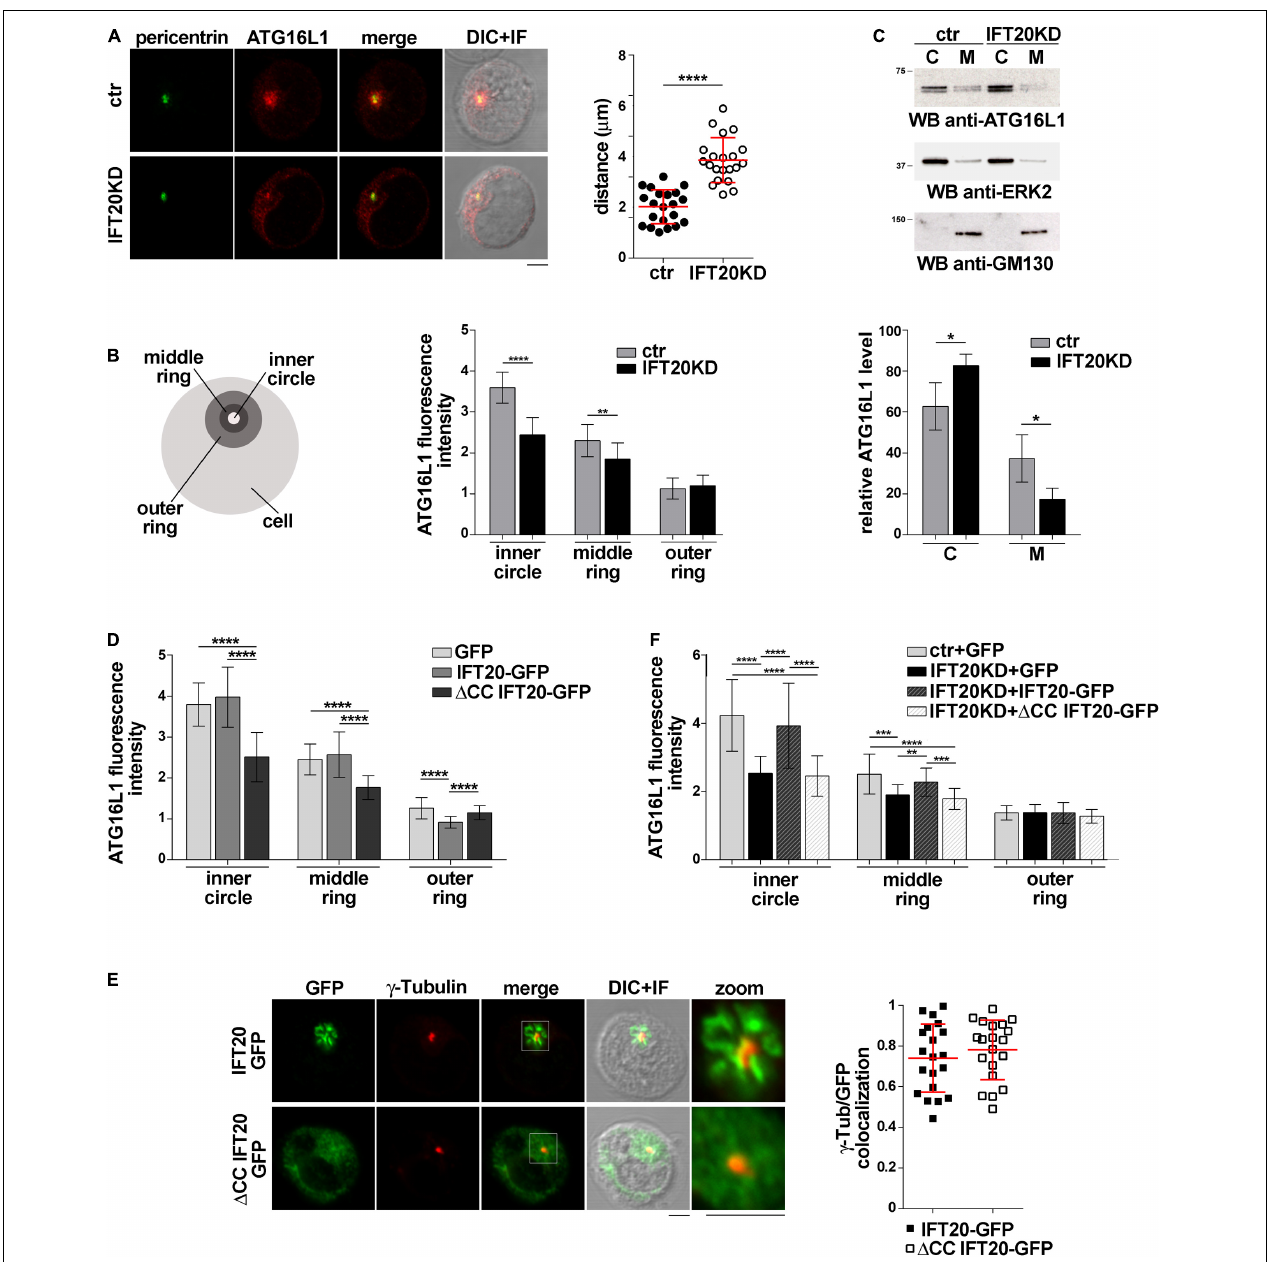
FIGURE 2 | IFT20 regulates the intracellular localization of ATG16L1. (A,B) Immunofluorescence analysis of ATG16L1 and the centrosomal protein pericentrin in control (ctr) and IFT20KD Jurkat cells. Representative medial optical sections and overlay of immunofluorescence and DIC images are shown (IF + DIC). Scale bars: 5 µ m. (A) The graph shows the quantification of the distance of ATG16L1 + vesicles from the centrosome (mean ± SD, 21 cells; n = 3; Student’s t -test). (B) Histogram showing the quantification of fluorescence intensity in the concentric regions indicated in the scheme and defined from the point of ATG16L1 maximal intensity (mean ± SD, ≥ 20 cells/sample; n = 3; Mann–Whitney test). (C) Immunoblot analysis of ATG16L1 in cytosolic (C) and membrane (M) fractions purified from control and IFT20KD Jurkat cells. The cytosolic protein ERK2 and the cis -Golgi marker GM130 were used to assess the purity of cytosolic and membrane fractions, respectively. The migration of molecular mass markers is indicated. The histogram shows the quantification of the percentage of ATG16L1 in the cellular fractions obtained from 4 independent experiments (mean ± SD; Student’s t -test). (D) Immunofluorescence analysis of ATG16L1 in GFP, IFT20-GFP, and (cid:49) CC IFT20-GFP Jurkat transfectants. The histograms show the quantification of fluorescence intensity in the concentric regions described above (mean ± SD, ≥ 25 cells/sample; n = 3; Mann–Whitney test). (E) Quantification (using Mander’s coefficient) of the weighted colocalization of γ -tubulin with GFP in medial confocal sections